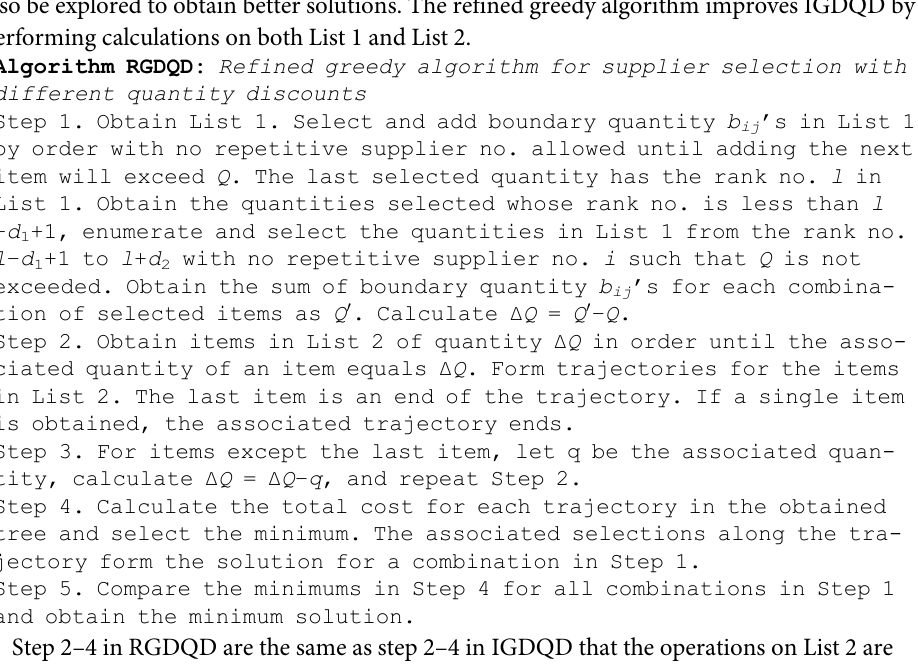
Algorithm RGDQD: Refined greedy algorithm for supplier selection with different quantity discounts